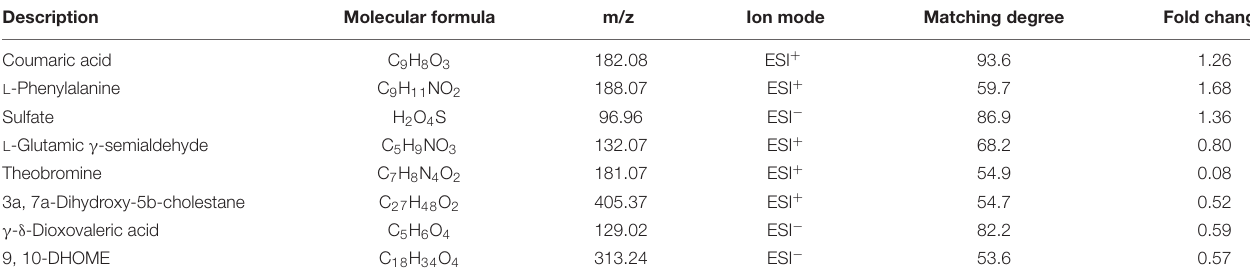
TABLE 3 | List of metabolites that were present at differing plasma concentrations in the SAA and healthy control groups.